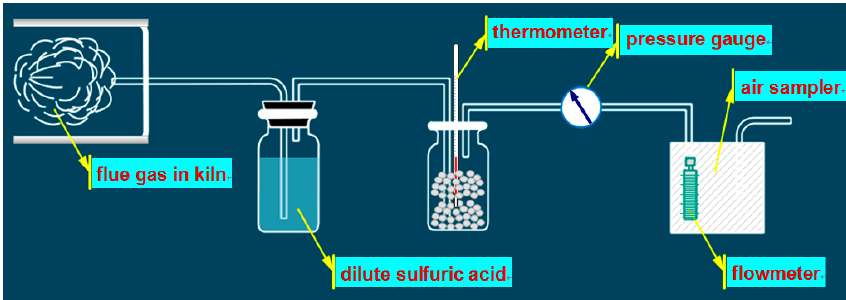
Figure 2. Schematic diagram of the determination for ammonia slip.